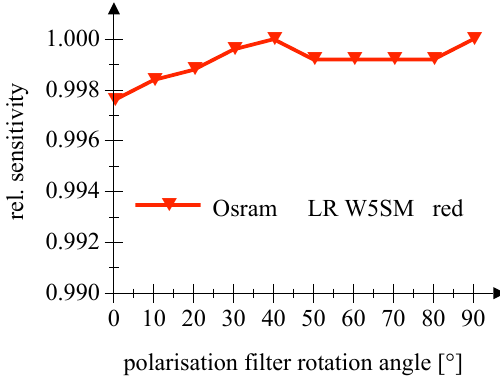
Figure 15. This figure shows the measured sensitivity as a function of the polarization angle for a red Osram LED employed as PD.